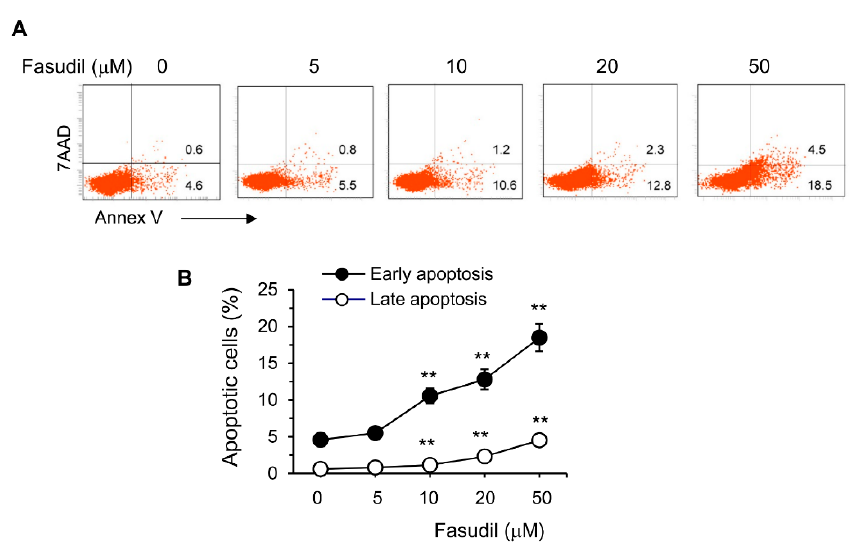
Figure 6. Fasudil promotes apoptosis of hepatic stellate cells. HSC-T6 cells were cultured for 2 days without or with fasudil (0–50 µM). Cells were collected and processed for 7AAD/Annex V staining. ( A ) Representative dot plots and ( B ) the percentages of early (Annex V + / 7AAD − ) and late (Annex V + / 7AAD + ) apoptotic cells are summarized in a linear graph. Results (mean + SD of triplicates) are representative of two independent experiments. ** p < 0.01 vs. PBS-treated groups.